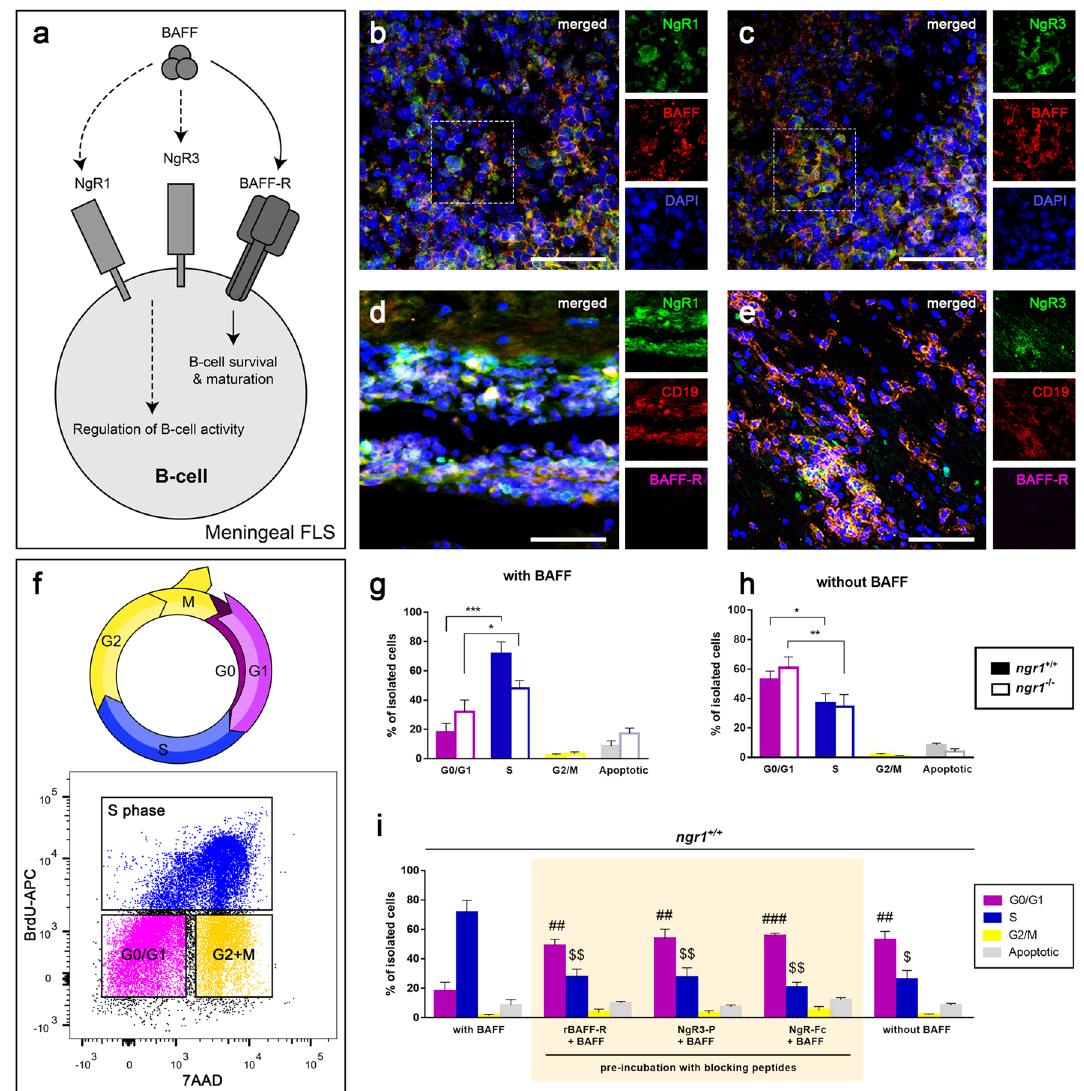
Figure 3. BAFF play a role in stimulating B-cells that express NgR1 and NgR3 during the disease onset of EAE. ( a ) Schematic representation of the potential BAFF/NgR-dependent mechanism operative during the induction of EAE. ( b , c ) Substantial numbers of clustered immune cell infiltrates that co-labeled either BAFF and NgR1 or, BAFF and NgR3, were found within the spinal cord of ngr1 + / + EAE-induced mice at disease onset. ( d , e ) No double-positive immune cells co-expressing BAFF-R with NgR1 and NgR3 were identified in infiltrates of the spinal cord in ngr1 + / + mice. Hatched boxes are further apposed in separate channels; scale = 50 μm. ( f ) Cell cycle assessment (G1, gap 1 phase; S, synthesis; G2, gap 2 phase; M, mitosis) with flow cytometric analysis showing the gating for the cell cycle phases; G0/G1 (purple color), S phase (Blue), G2/M phase (yellow); BrdU, 5-Bromo- 2 ′ -deoxyuridine; 7AAD, 7-aminoactinomycin D (7AAD). ( g , h ) NgR1 + and NgR3 + B-cell population was either stimulated with 50 ng/mL recombinant BAFF (with BAFF) or left untreated (without BAFF). BAFF stimulation led to a significant increase in DNA synthesis (S phase compared to G0/G1 phase; n = 12; t test *** p < 0.001) of isolated cells from ngr1 + / + mice while cells remained in the G0/G1 phase (n = 12; t test * p < 0.05) in the absence of BAFF. Isolated cells from ngr1 −/ − mice also exhibited significant differences between the G0/G1 and S phases in the BAFF-treated cultures (n = 10; t test * p < 0.05) and the untreated ones (n = 10; t test ** p < 0.01), highlighting the role of NgR3 in the absence of NgR1. ( i ) To identify NgR interactions with BAFF, rBAFF was blocked with an excess amount of either rBAFF-R, NgR1-Fc or NgR3-P. All three blocking peptides were efficacious at blocking the cell cycle-dependent BAFF activity when compared to the BAFF-treated cultures. Bars represent mean ± SEM; # p < 0.05, ## p < 0.01, ### p < 0.001 comparisons with the G0/G1 phase of the BAFF-treated cultures, t test (with Bonferroni correction); $ p < 0.05, $$ p < 0.01, $$$ p < 0.001 comparisons with the S phase of the BAFF- treated cultures, t test (with Bonferroni